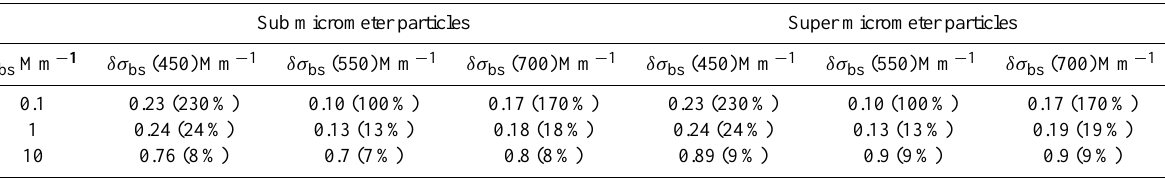
Table 2. Uncertainties ( δσ bs ) estimated for 30min averaging periods for backscattering coefficients ( σ bs ) ranging between 0.1 and 10Mm − 1 , for sub micrometer and super micrometer aerosol particles. Relative errors are shown in